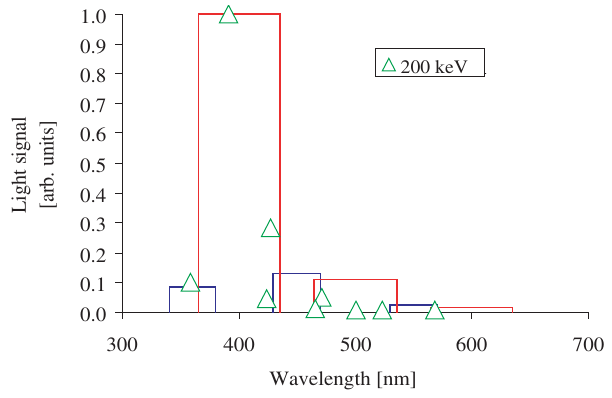
FIG. 15. (Color) Emission spectrum measurement. The boxes represent the relative amplitude measured over the filter band- width. The triangles are the spectroscopy results. Figure 15 was